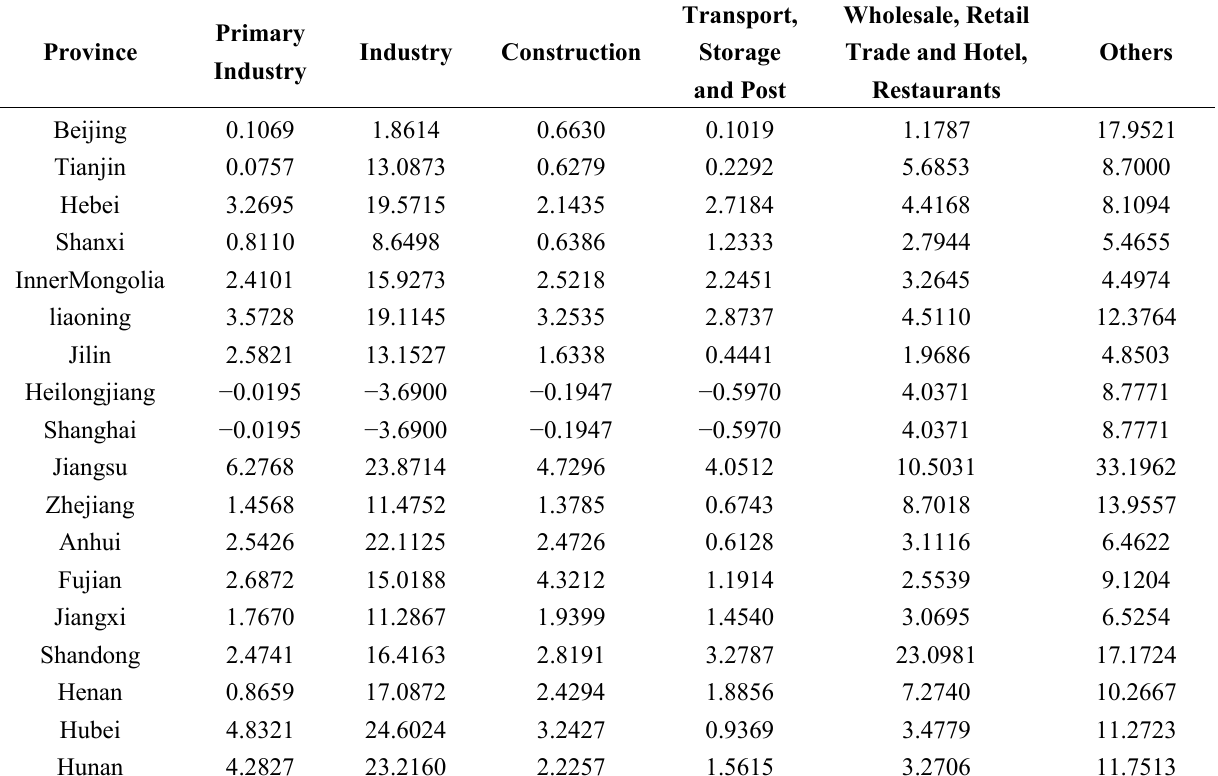
Table 2. Different parts of Chinese industrial structure’s contribution values to carbon